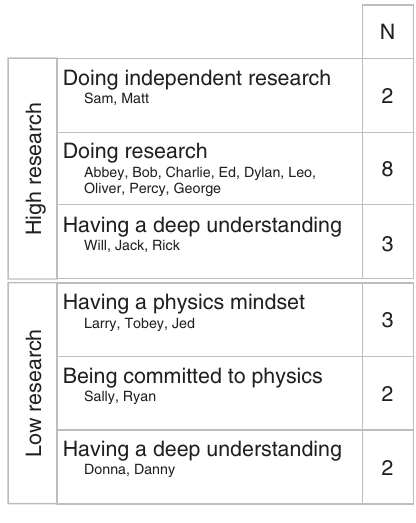
FIG. 1. Categories and subcategories of students ’ perceptions, and the number and pseudonyms of students in